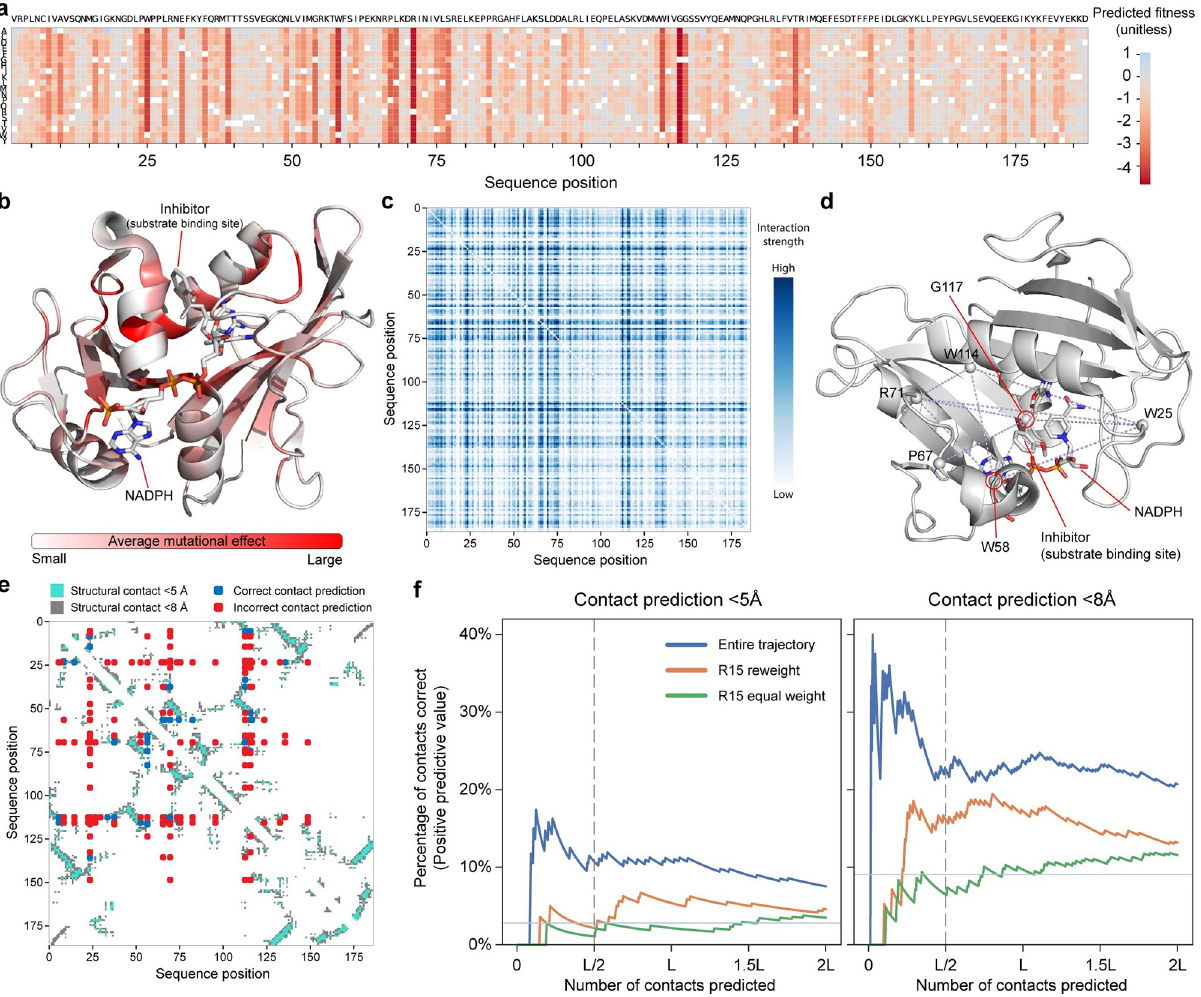
Fig 2. Model parameters relate to DHFR structure and function. (a) A heatmap of the model’s predicted mutational effects across the 186 DHFR sequence positions. The wild-type amino acid is colored in white. (b) The average mutational effect at each site mapped onto the DHFR structure (PDB ID: 3K47). The largest magnitude mutations tend to occur in the protein core and the substrate binding site. (c) The interaction strength between all pairs of sites in DHFR. The interaction strength is calculated as the Frobenius norm over the Potts model interaction coefficient all amino acid combinations at each pair of sites. (d) The top ten long range interactions plotted on the DHFR structure (PDB ID: 3K47). Many of these interactions occur through interactions through the substrate. (e) The top L/2 (93) interactions between residues plotted on a contact map showing residues with heavy atoms closer than 5 Å and 8 Å . (f) A comparison of contact prediction for pseudo-likelihood DCA models trained on R15 data, R15 data reweighted to account for evolutionary bias, or using our methods on the evolutionary trajectory. The horizontal line represents random chance and the vertical line is drawn at the commonly used L /2